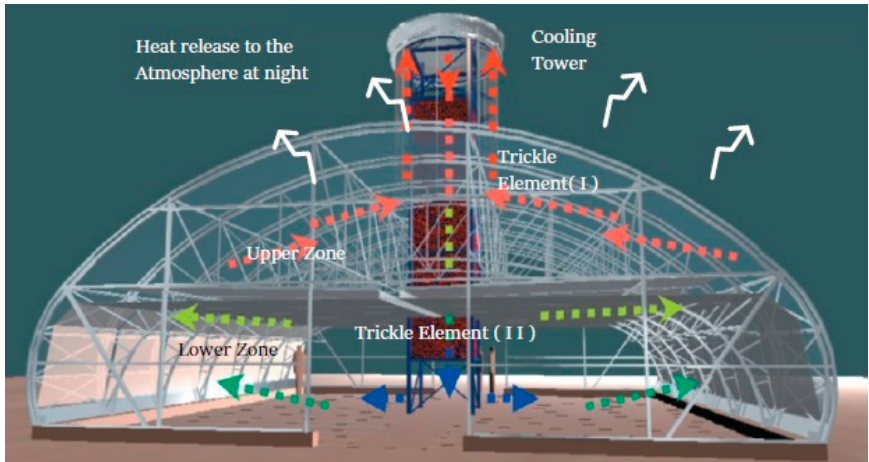
Figure 11. Thermal-storage-based systems used in greenhouses: ( a ) rock bed storage; ( b ) PCM storage. Reprinted with permission from Ref. [152]. Copyright 2018 Elsevier.